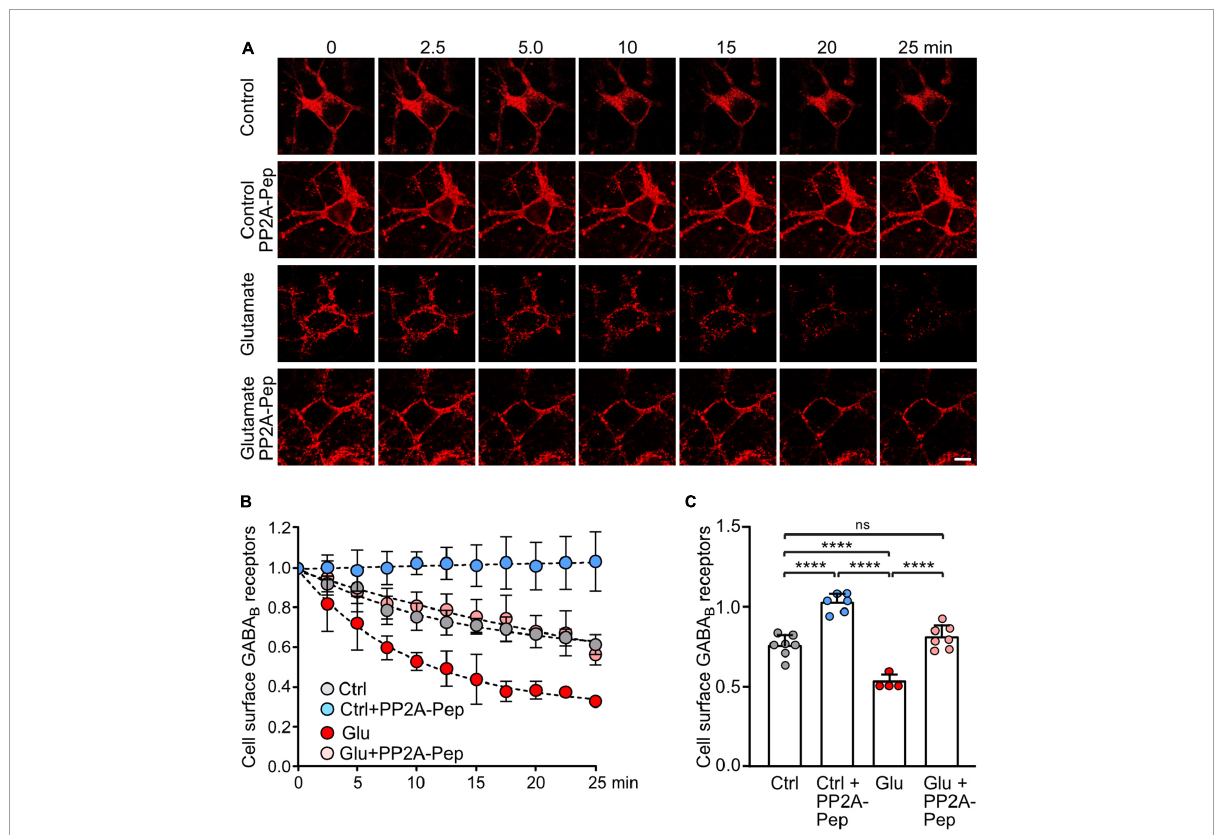
FIGURE4 PP2A-Pep prevents constitutive internalization of GABA B receptors and normalizes glutamate-induced loss of cell surface receptors. Neurons were transfected with GABA B2 tagged with the binding site for α -bungarotoxin [GABA B2 (BBS)] along with EGFP for quick identification of transfected neurons and with wild type GABA B1 . After labeling cell surface receptors containing GABA B2 (BBS) with AlexaFluor 555 conjugated α -bungarotoxin at 4 ◦ C, neurons were analyzed at room temperature by life cell imaging for internalization of labeled receptors at the indicated time points and treatments. (A) Representative images (scale bar: 10 µ m). (B) Quantification of the immunofluorescence signal. (C) Statistical evaluation of data 10 min after initiation of internalization. The data represent the mean ± SD of 4–7 neurons derived from three independent experiments. Two-way ANOVA followed by Tukey’s multiple comparison test (ns, p > 0.05, **** p <